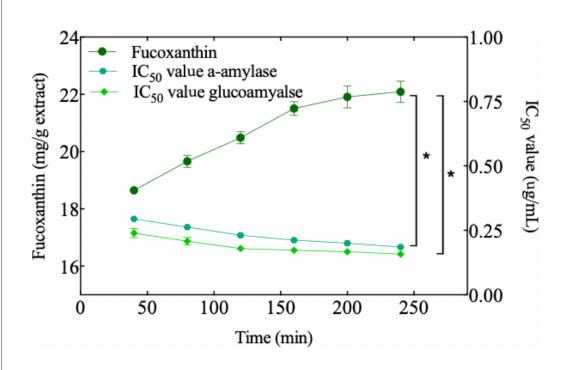
FIGURE5 The amount of fucoxanthin produced as a function of time at constant extraction pressure, temperature, sample size, CO 2 flow, and entrainer (6000 psi, 65 ◦ C, 450 µ m, 2.5 ml/min, and 1.25 ml). The IC 50 value of several experiments against two enzymes ( α -amylase and glucoamylase). A significant difference ( t -test, p < 0.05) is indicated with an